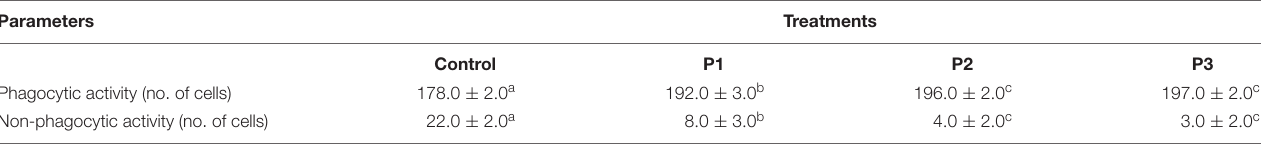
TABLE 4 | Phagocyte activity of shrimp in treatments with different levels of P. pentosaceus .